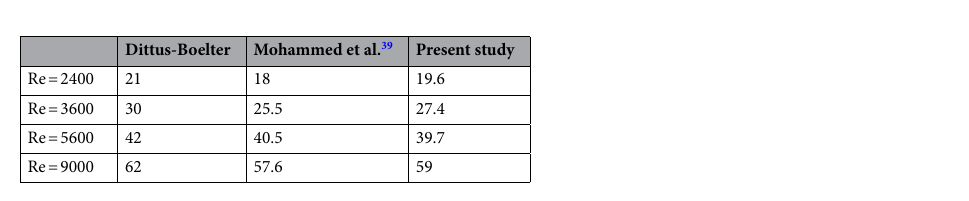
Table 3. Comparison between the present results and those of previous works 39 and Dittus-Boelter